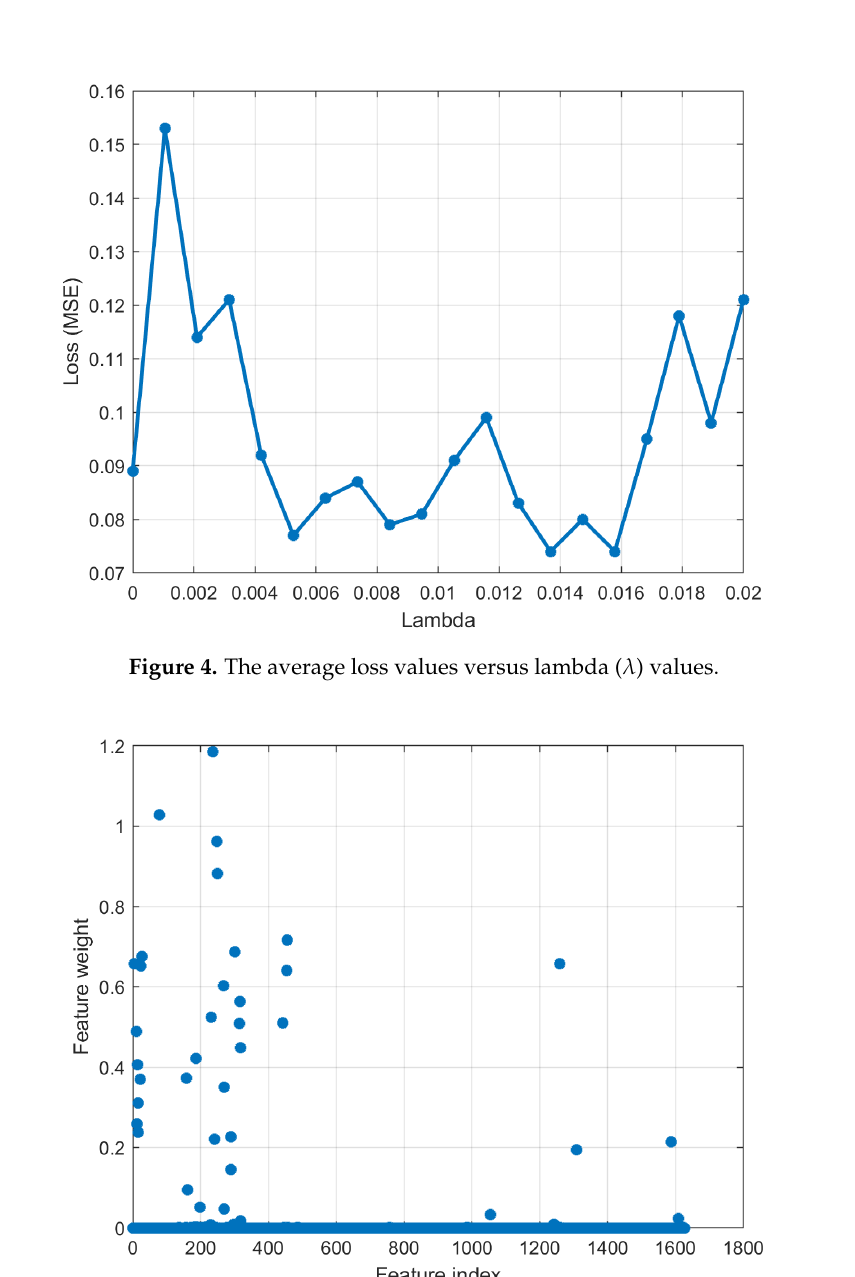
Figure 5. The selected features/miRNAs according to NCA feature weights. A higher weight value indicates better discrimination power. A threshold of 0.02 was applied to reduce the number of miRNAs to